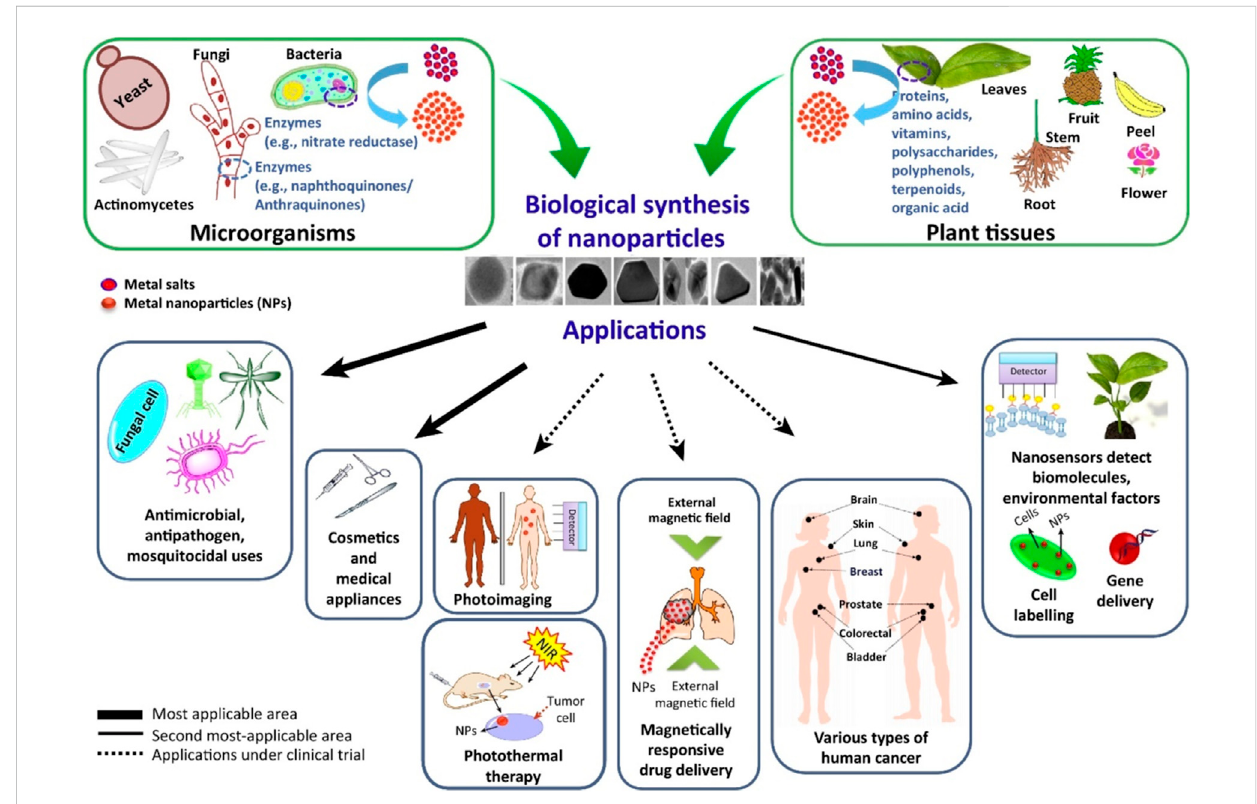
FIGURE 7 Summary of various applications of metal nanoparticles in biomedical and environmental fi elds. Adapted from Ref. (Singh et al,